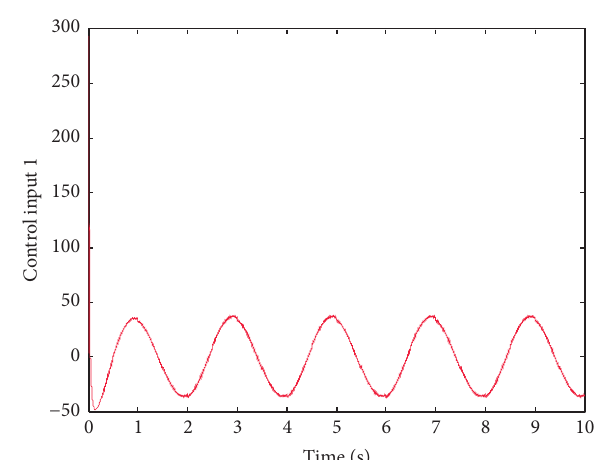
Figure 5: Control input signal 𝑢 1